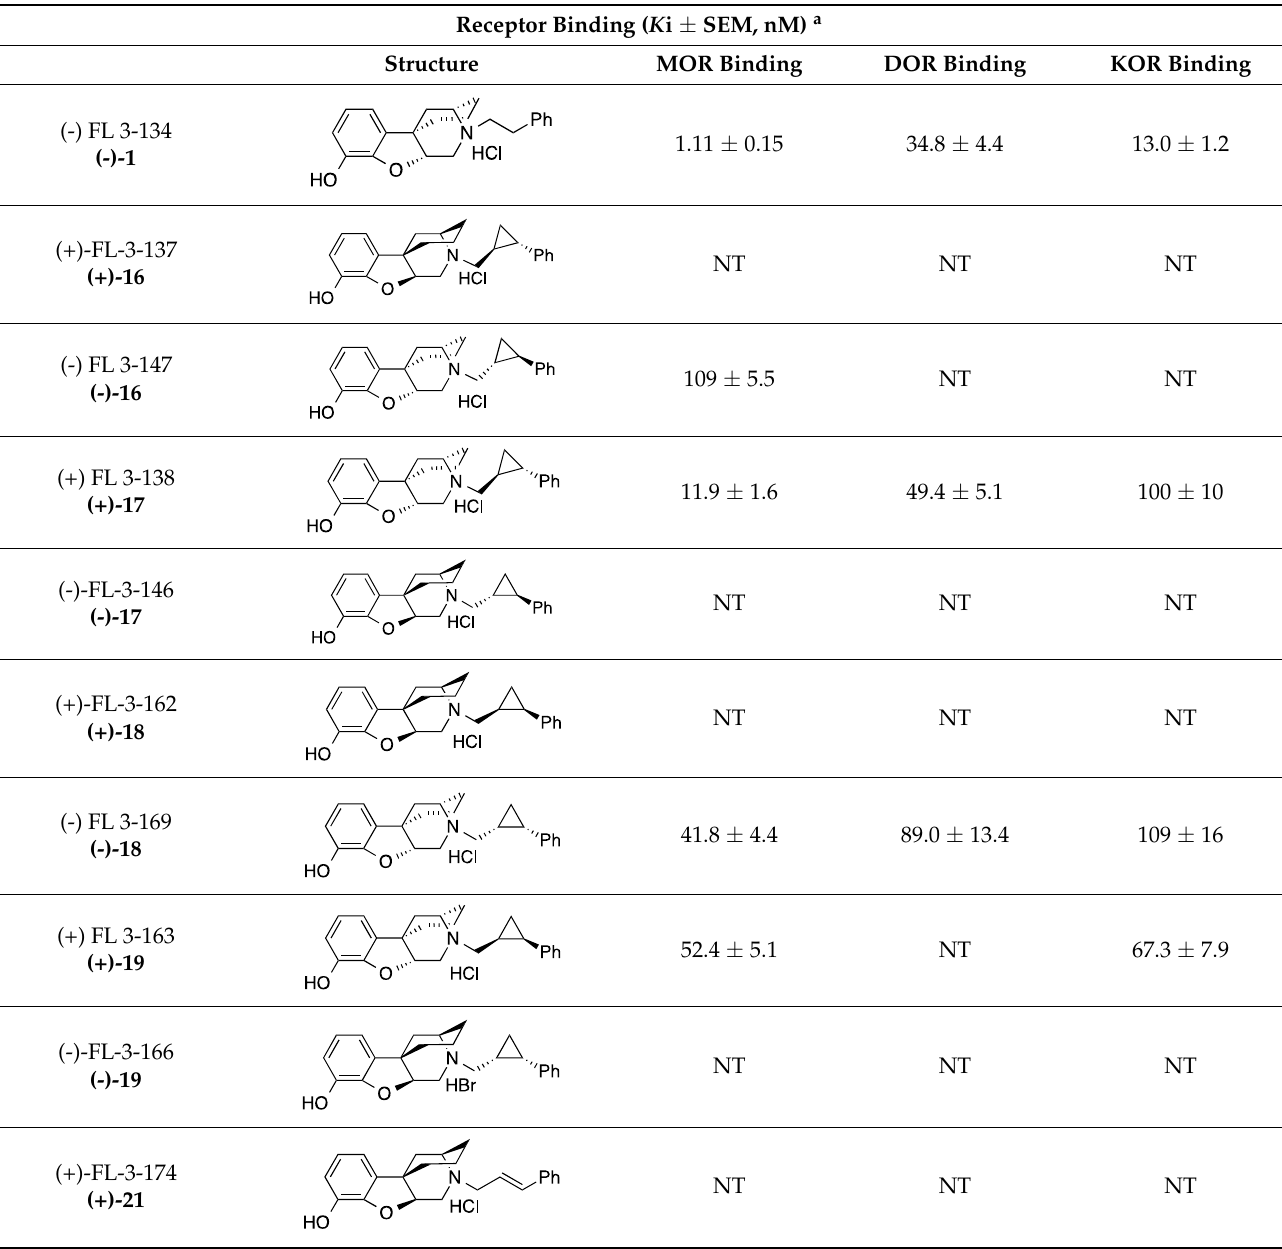
Table 1. Opioid receptor binding data for the enantiomeric ortho-C-phenylmorphans. Receptor Binding ( K i ± SEM, nM) a Structure